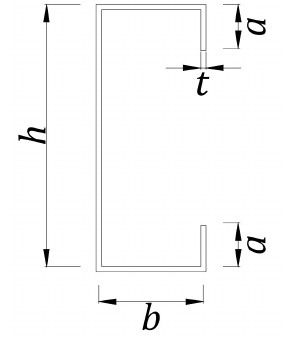
Figure 1. Definition of symbols.